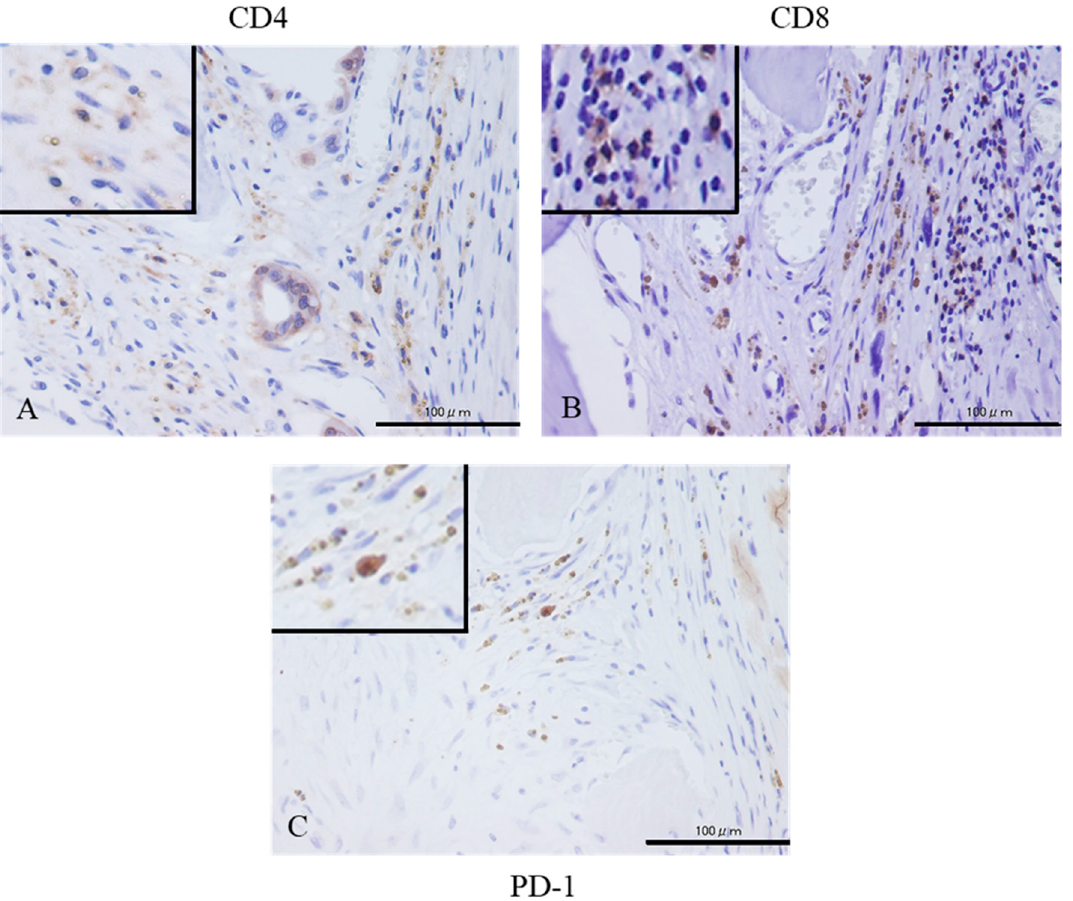
Figure 2. The larger microscopic view of CD4 ( a ), CD8 ( b ), and PD-1 ( c ) immunostaining (magnification. Immunostaining results of CD4, CD8, and PD-1 in adjacent sections are shown 400×) Tumor-infiltrated lymphocytes (TILs) present at the same or nearby site can be seen in each stain. The inset in the upper left corner of each image is an enlarged image, showing CD4, CD8, PD-1-positive TILs. Scales bar = 100 µm.